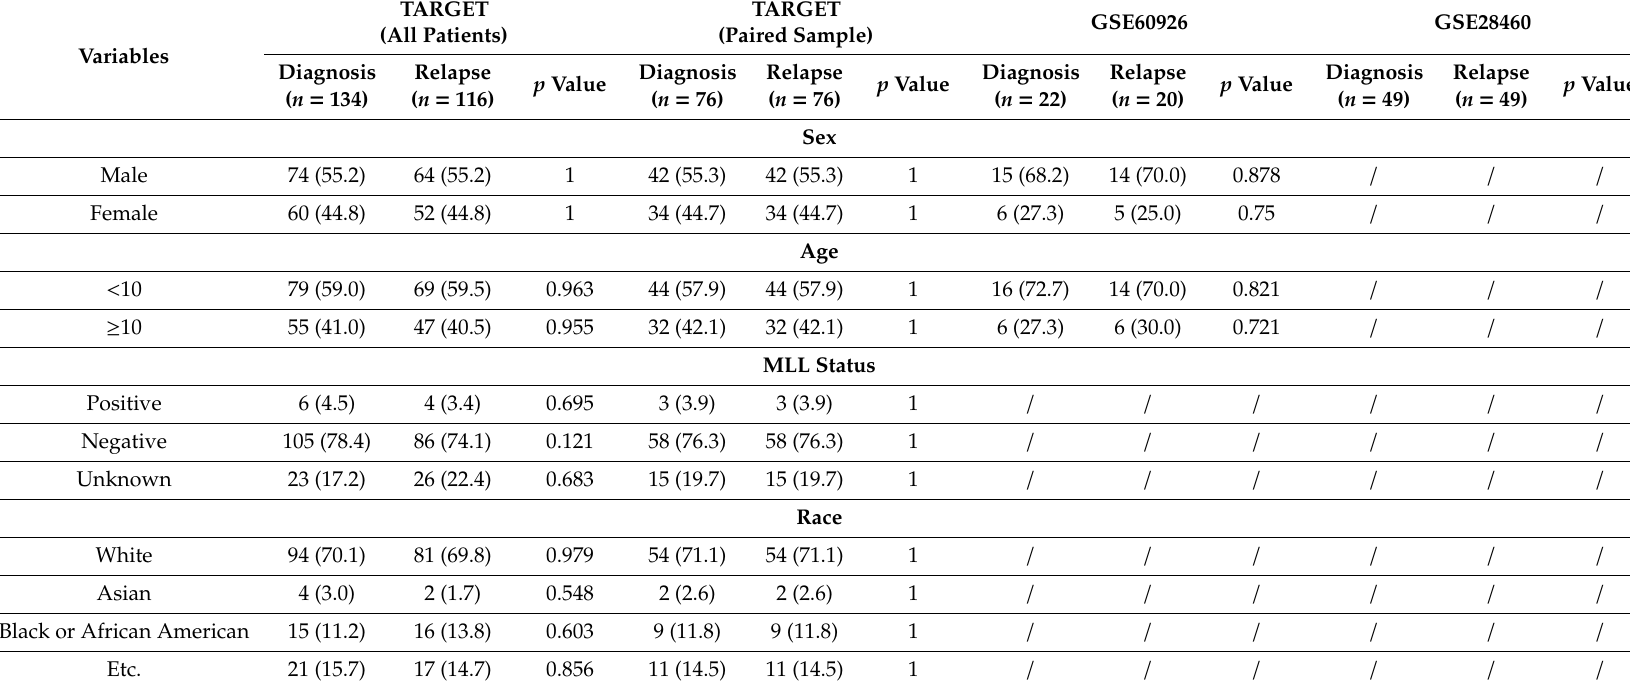
Table 1. Patient characteristics in the four